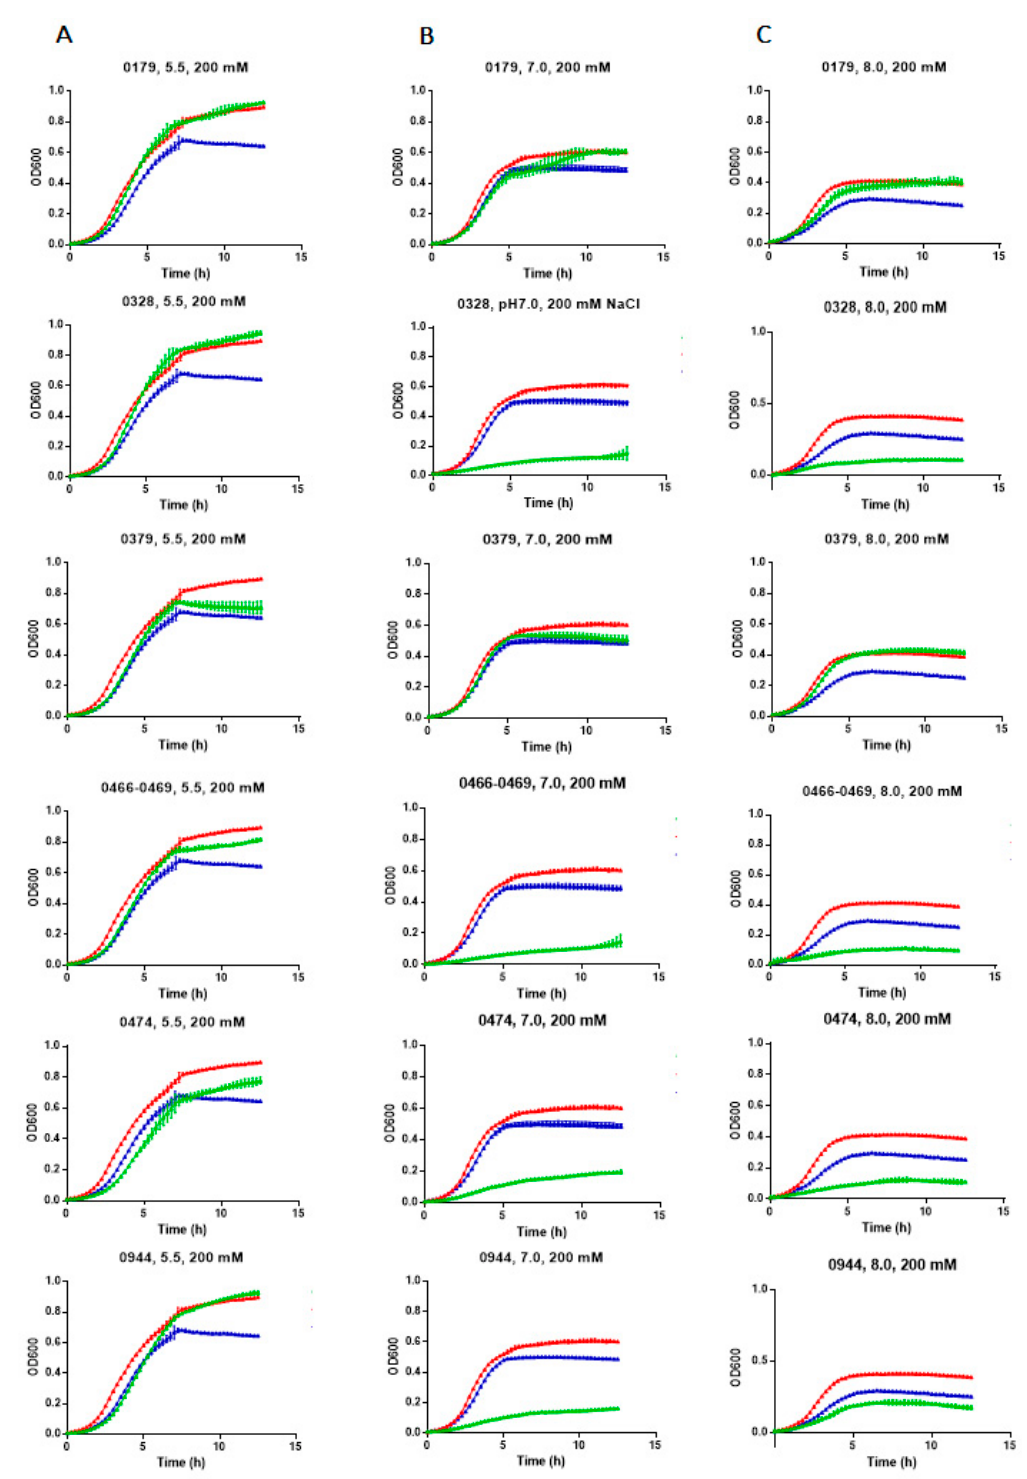
Figure 4. E. chaffeensis antiporters restored the growth of a salt-sensitive sodium/proton antiporter deficient strain of E. coli . The growth curves were measured by monitoring the OD at 600 nm over a period from 15 min to 13 h. The salt-stress was induced by the inclusion of 200 mM NaCl in LB media at varying pH conditions—5.5, 7.0, or 8.0—for all E. chaffeensis antiporter gene-containing EP432 strains (green lines). The E. coli transformed with the non-recombinant plasmid (blue line) or the plasmid-containing E. coli antiporter gene ( nhaA ) (red line) served as negative or positive controls, respectively. E. coli growth curves assessed at pH 5.5 ( A ), 7.0 ( B ) and 8.0 ( C ) are